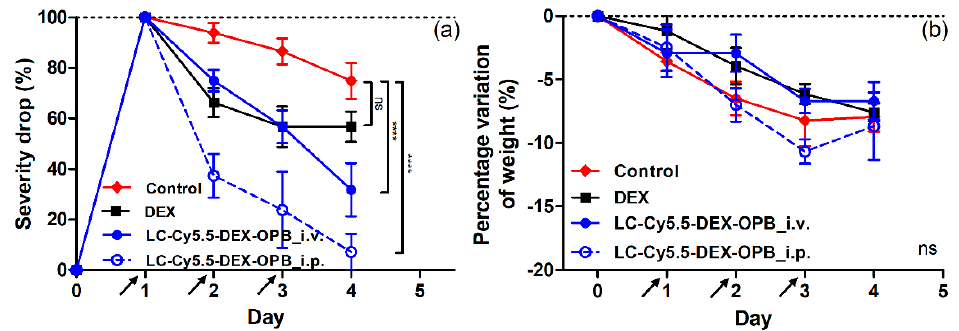
Figure 8. Decrease of the CS of the inflammation of mice in the ankle ( a ) and decrease of the weight ( b ) of the mice in the therapeutic experiment with dosing 3 × 1 mg DEX or DEX-OPB/kg. n = 6. The anti-inflammatory activity was also determined by the amount of ROS in inflamed tissue (right paw) using bioluminescence of 3-aminophthalhydrazide monosodium salt, see Supplementary